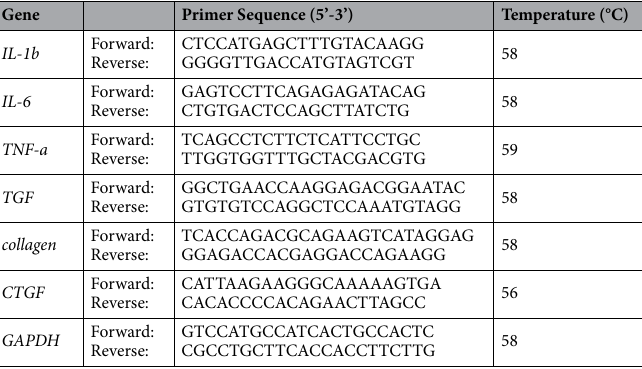
Table 1. List of primers used for reverse transcriptase-polymerase chain